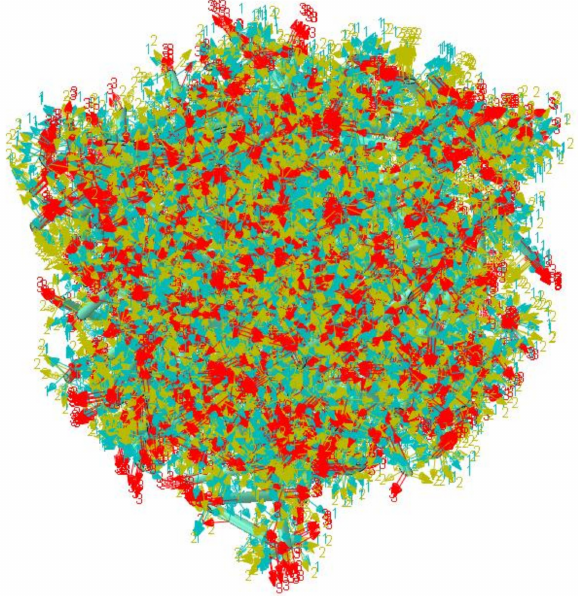
Figure 10. Schematic diagram of fiber local coordinate system